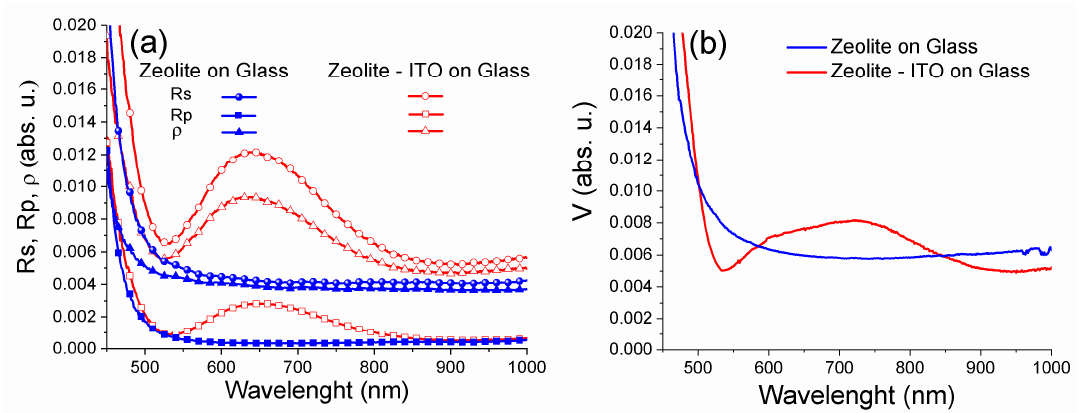
Figure 5. Polarization spectral characteristics of the zeolite 3A–carbon coatings: ( a ) amplitude and ( b ) phase anisotropy.